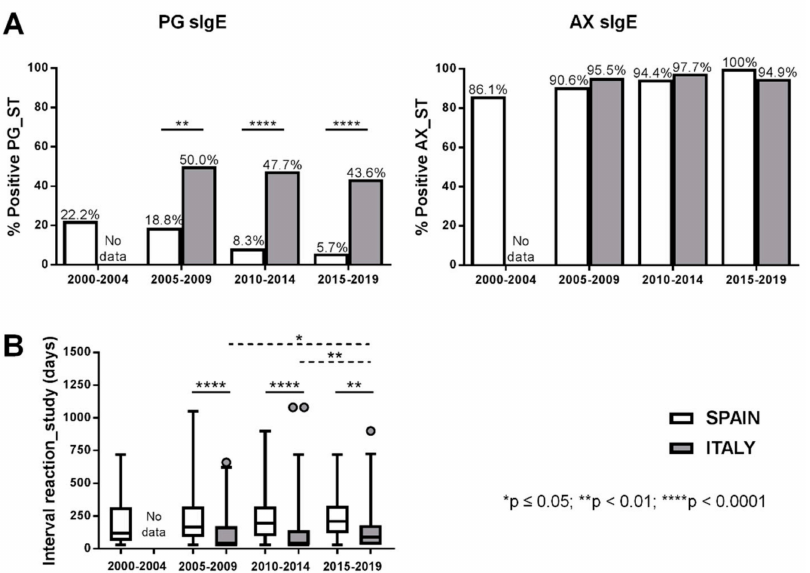
Figure 3. ( A ) Time interval between the reaction and the allergy work-up. ( B ) Percentage of patients with positive skin tests PG or to AX over time. Significant differences if p ≤